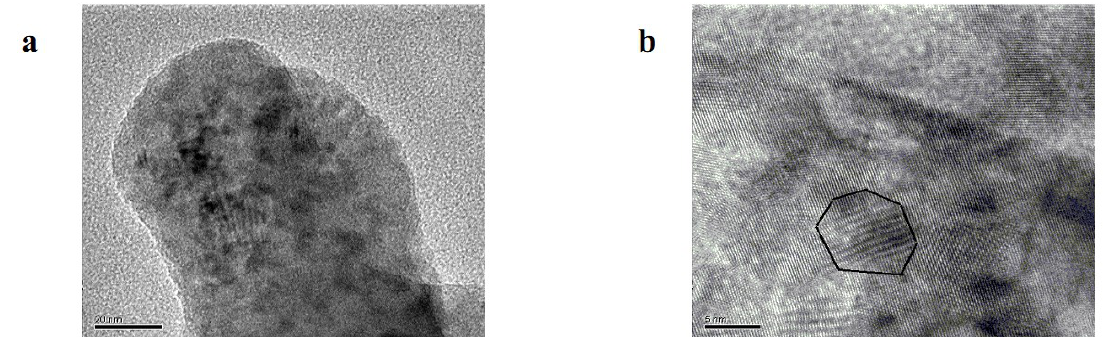
Fig. 6. The high resolution TEM images of (C phous nanopowder keeping ScCO with clearly observable crystallites that were created in the result of enhancing/nutriting (a) by milk,